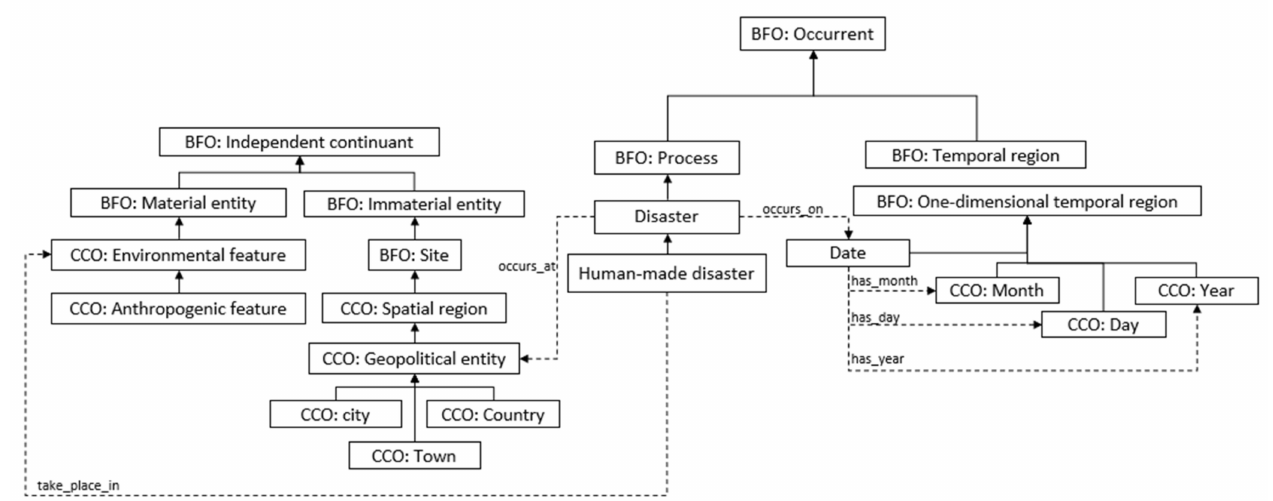
Figure 8. Spatial and temporal regions of a